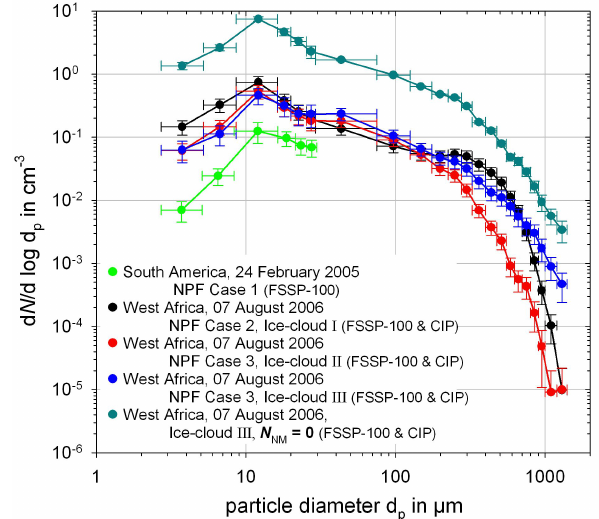
Fig. 10. Cloud particle size distributions as function of particle di- ameter, d p , measured by the FSSP-100 (24 February 2005), and the combination of FSSP-100 with Cloud Imaging Probe (CIP, 7 August 2006). Vertical error bars: uncertainties of the instruments detection volumes and due to counting statistics. Horizontal bars: Particle size bin width. Cases as defined in previous figures.